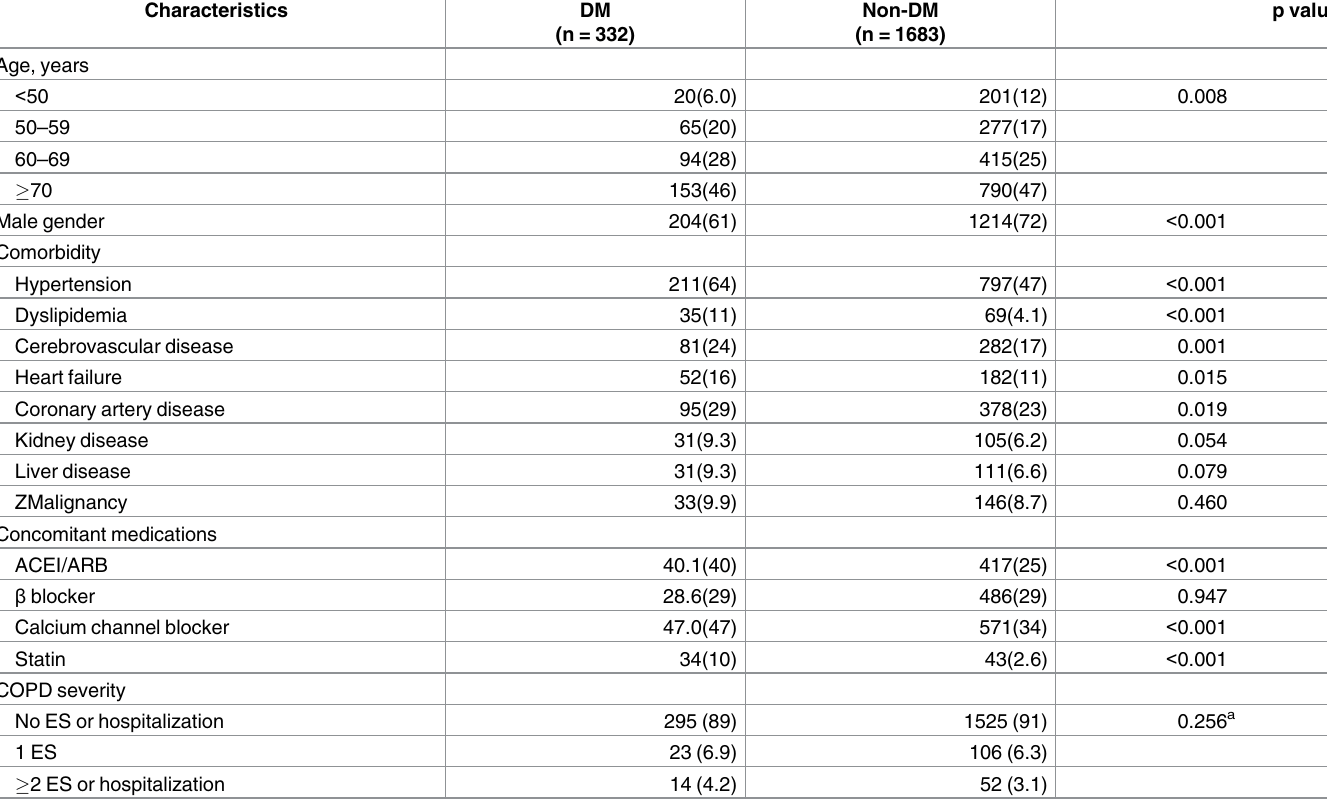
Table 1. Characteristics of all study patients with and without pre-existing DM at COPD diagnosis (n = 2015).